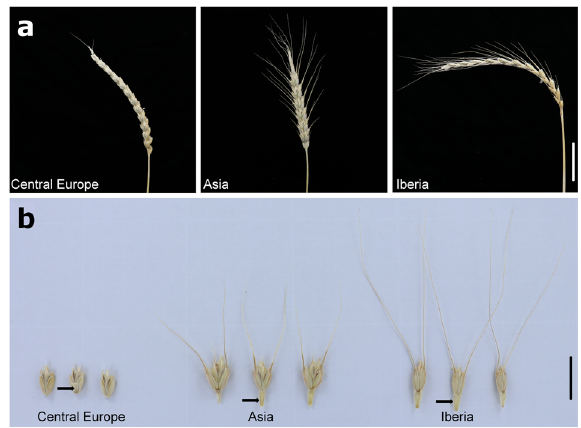
Fig. 1 Spike morphology and spikelet disarticulation in spelt. a Representative spikes of spelt accessions collected in Central Europe, Asia, and the Iberian Peninsula. Scale bar = 5 cm. b Spikelet disarticulation of spelt. Spikelet disarticulation in plants with brittle rachis can be classi fi ed as barrel-type (upper rachis segment pressed against the lower spikelet) and wedge type (rachis segment pointing down). Central European spelt shows a barrel-type disarticulation, whereas disarticulation in Asian and Iberian spelt is of the wedge type. Scale bar = 2 cm. Arrows point to the rachis segment after spikelet